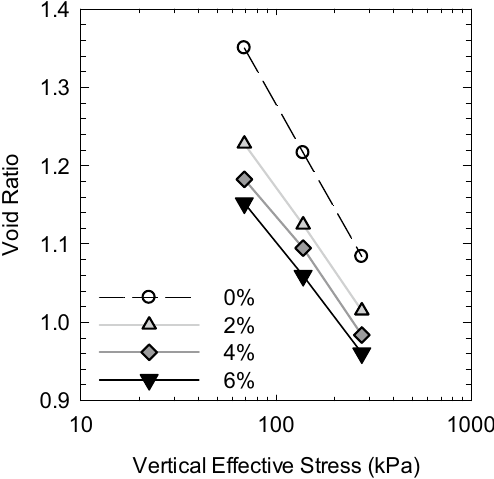
Figure 10. Triaxial compression curves of soft marine clay with different